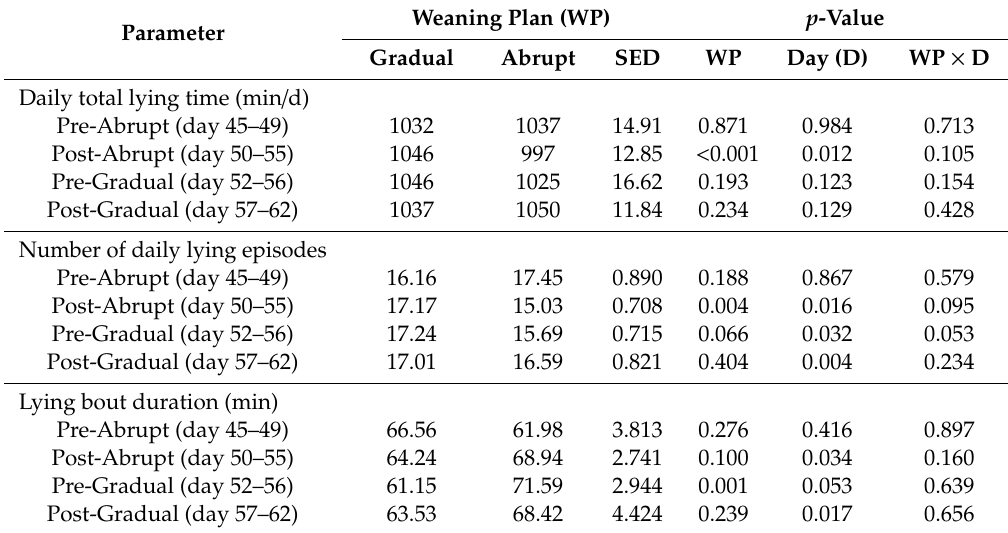
Table 5. Daily lying duration, number of lying bouts and lying bout duration over the pre-and post-weaning periods.